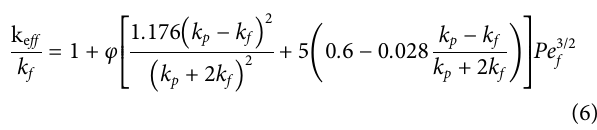
Frontiers in Energy Research |